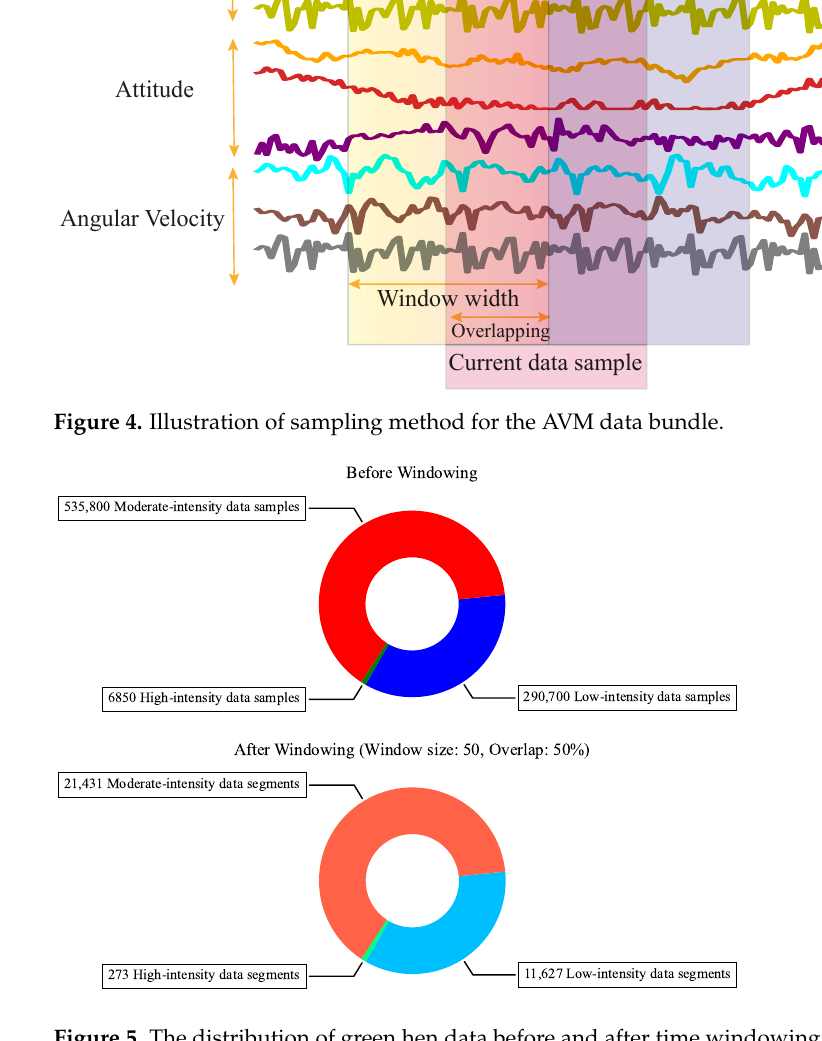
Figure 5. The distribution of green hen data before and after time